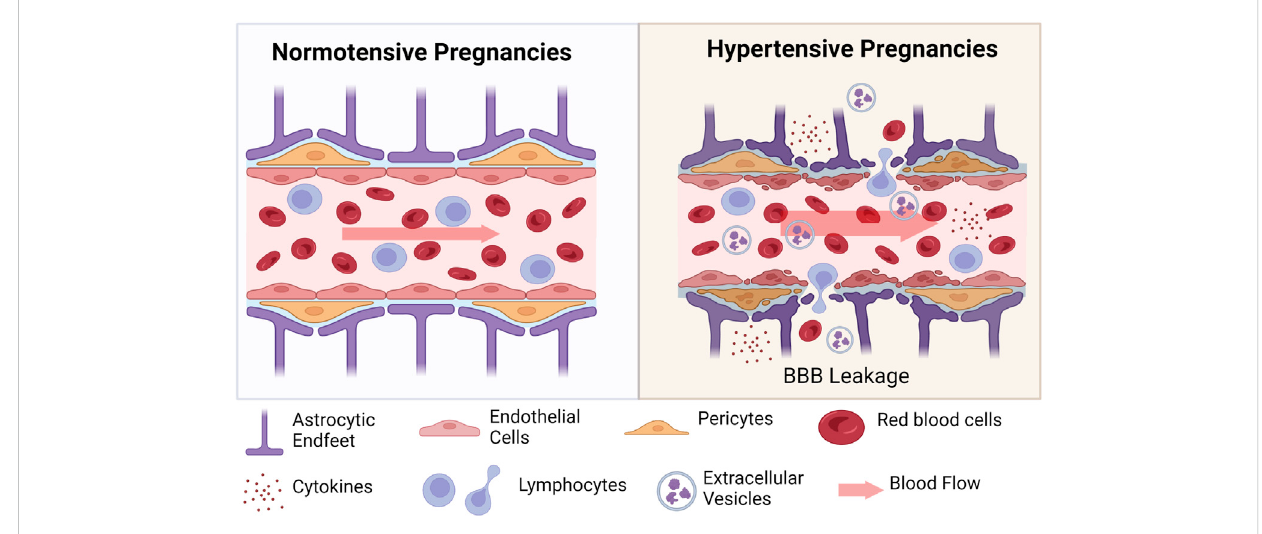
FIGURE 3 Schematicofchangesattheblood-brainbarrierinhypertensivepregnancies.Duringhypertensivepregnancies,allcellsoftheneurovascularunitare impacted.Endothelialcells, pericytes, andastrocytic endfeetaredamagedunderconditionsofincreased blood fl ow(indicated bywiderarrow).Damage to these cells results in extravasation of blood cells (red blood cells and various lymphocytes) into the surrounding tissue. In fl ammatory cytokines and anti-angiogenic factors are also secreted into the cerebral tissues. Created with